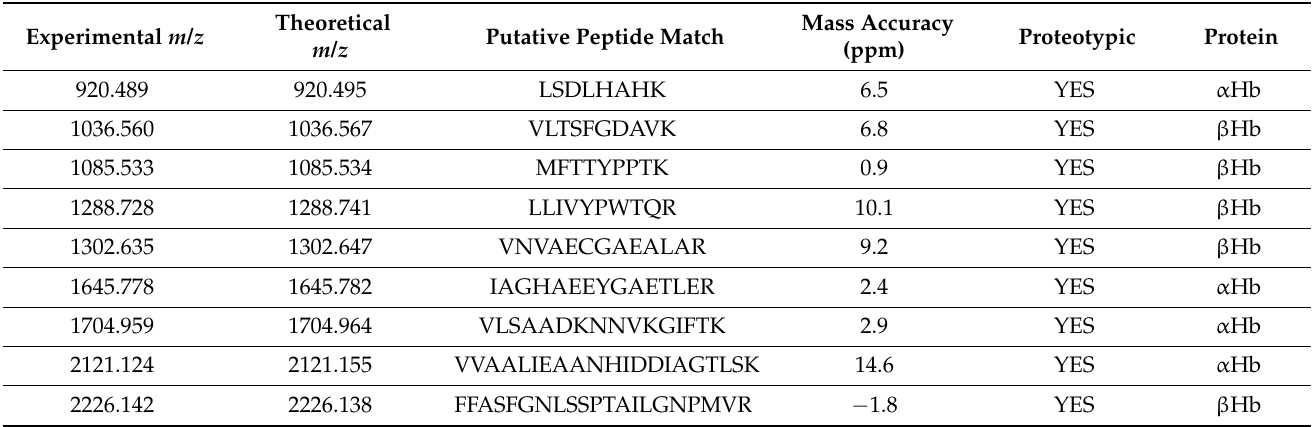
Table 3. Putatively identified peptides from the MALDI MS spectra of proteolysed chicken intra- venous blood. All protein matches found in the intravenous chicken blood were proteotypic to this